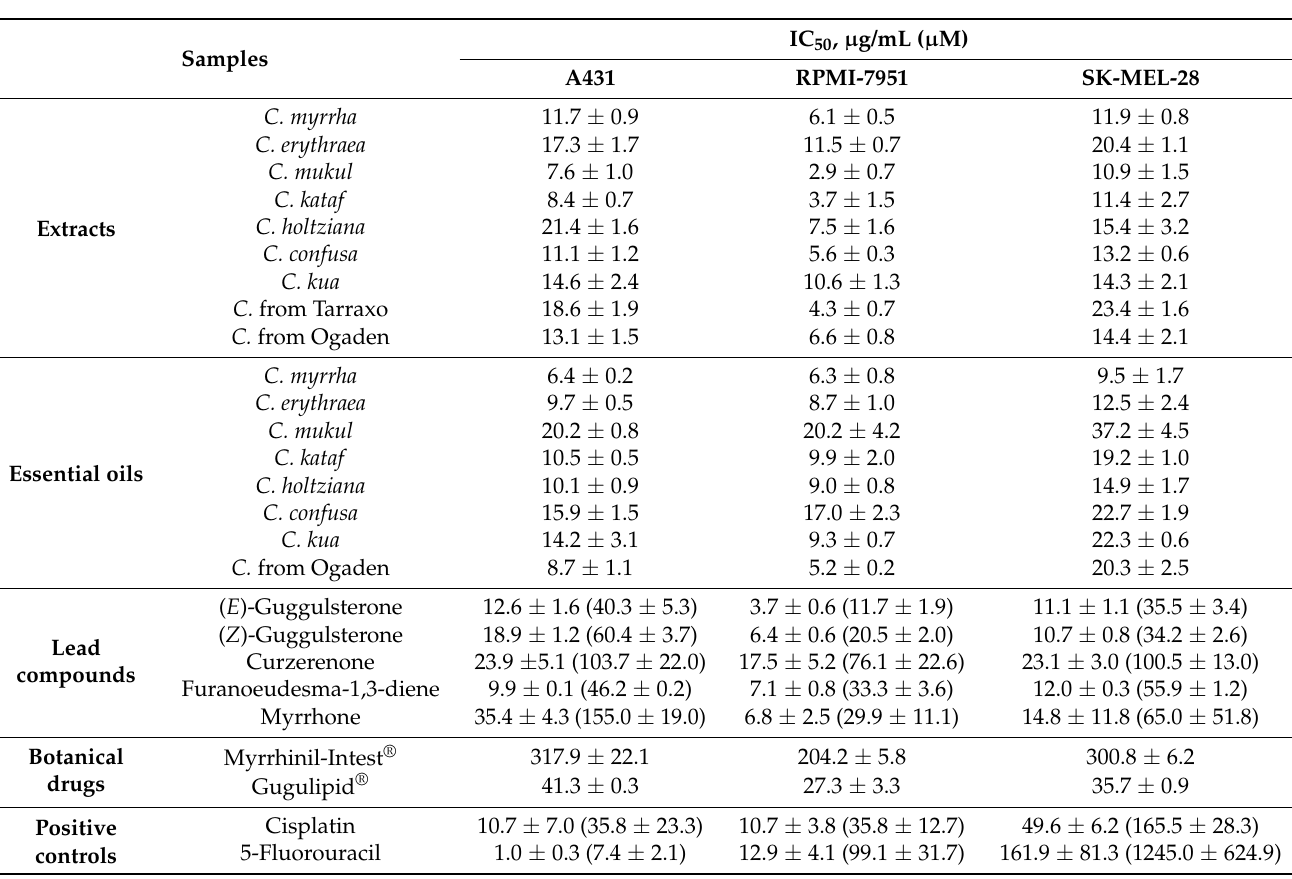
Table 5. Cytotoxic efficacies of Commiphora extracts and essentail oils against the epidermoid car- cinoma cell line A431 and the malignant melanoma cells lines RPMI-7951 and SK-MEL-28. Half maximal inhibitory concentrations (IC 50 ) are given in µ g/mL, and for pure compounds, additionally in brackets as µ M. XTT assay, 72 h. All data were mean ± SEM of three biological samples, each analyzed in